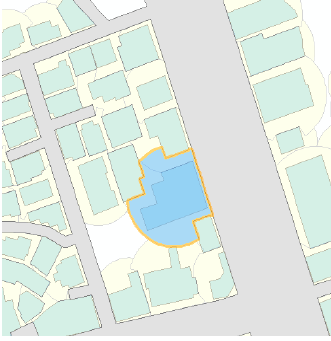
Figure 5. Isovist area created from a viewpoint.